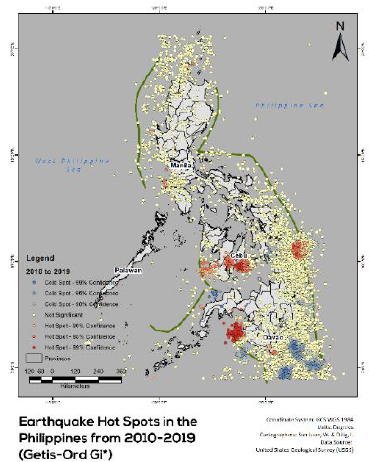
Figure 19. Temporal Analysis of Earthquake Hot Spots in the Philippines from 2010 to 2019